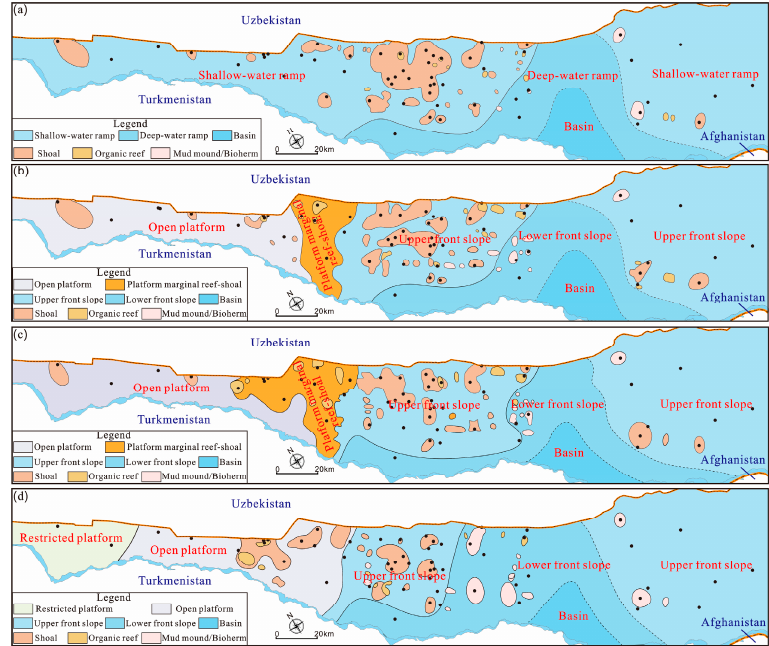
Figure 8. Sketch map showing distribution of sedimentary facies and paleogeography of Callovian-Oxfordian Stage in Amu Darya Basin (( a ) layer XVa2; ( b ) layer XVa1; ( c ) layer XVm; ( d ) layer XVp)).